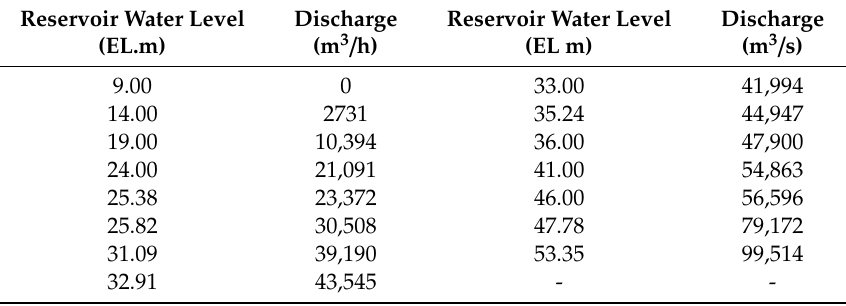
Figure 5. DAMBRK simulation results. ( a ) dam inflow scenario; ( b ) maximum water surface elevation. Table 2. Spillway Water Level-Discharge Data.